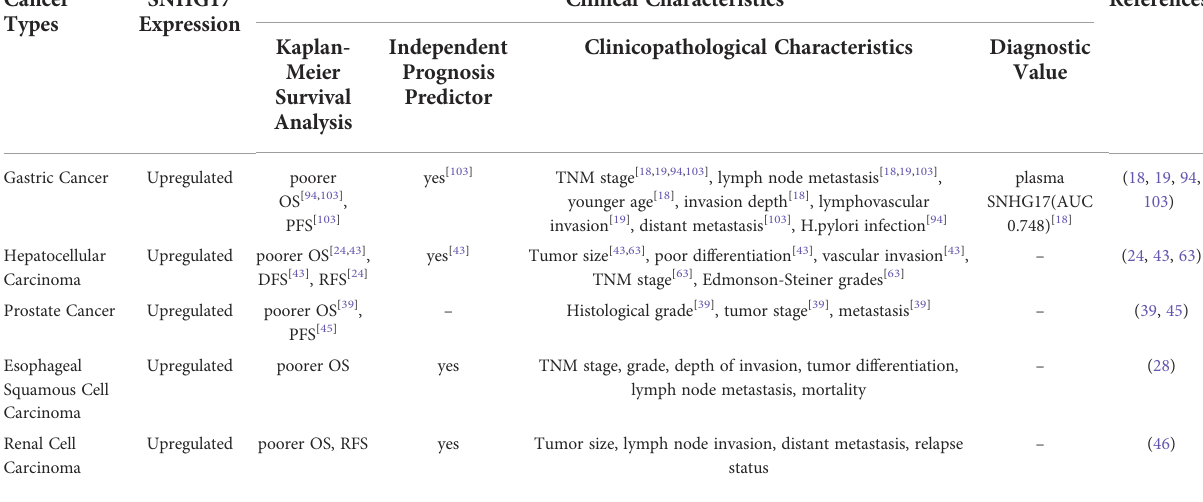
TABLE 1 Expression and clinical signi fi cance of SNHG17 in human